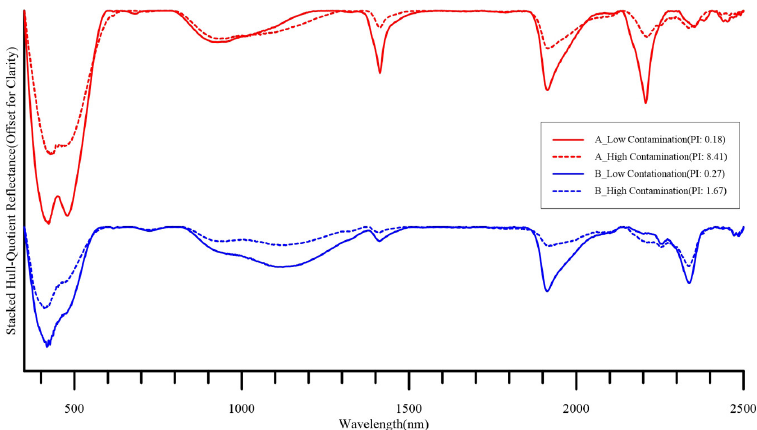
Figure 5. The hull quotient corrected reflectance spectra of highest and lowest pollution index by each group.